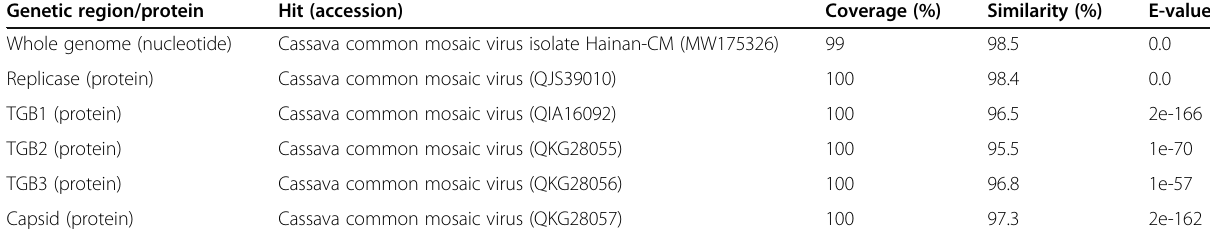
Table 1 Alphaflexiviridae nucleotide and protein similarity table, determined using BLASTn and BLASTp Genetic region/protein